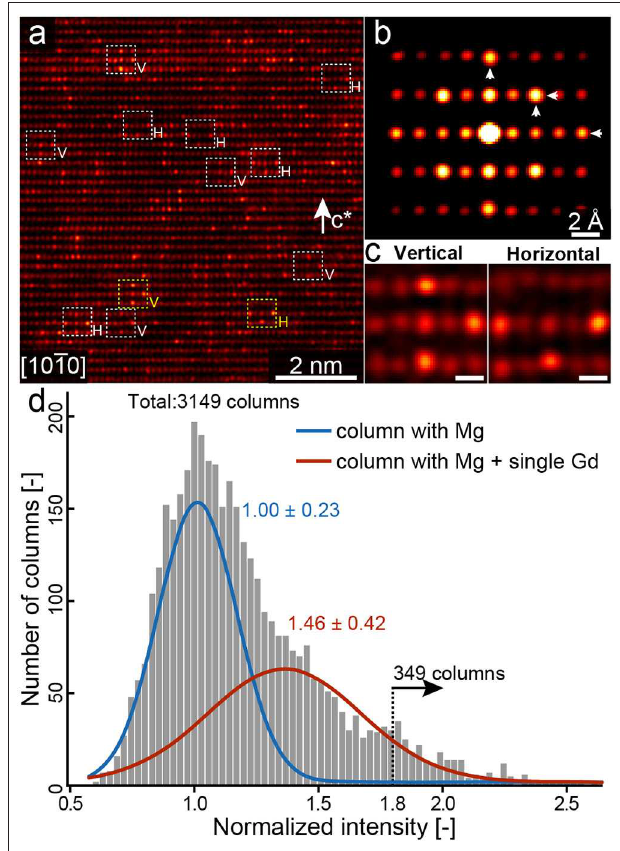
FIGURE 3 | (a) Enlarged HAADF-STEM image of the blue-box region in Figure 1d . c* denotes the c -axis of the matrix hcp crystal. (b) Auto-correlation pattern obtained from the image of (a) . (c) Representative local STEM images showing characteristic bright-dot arrangements, which are enlargements of those indicated by yellow dashed squares in (a) , being with scale bars of 2 Å. By using yellow-square regions as the references, the similar contrast regions indicated by white dashed squares have been selected according to cross-correlation evaluations. Details are described in the text. (d) Intensity distributions of the atomic columns in the image of (a) . Total number of the columns measured is 3,149. Blue and red lines represent gauss-fitting results; mean values, and standard deviations for each fitted-profile are 1.00 ± 0.23 and 1.46 ± 0.42, respectively.